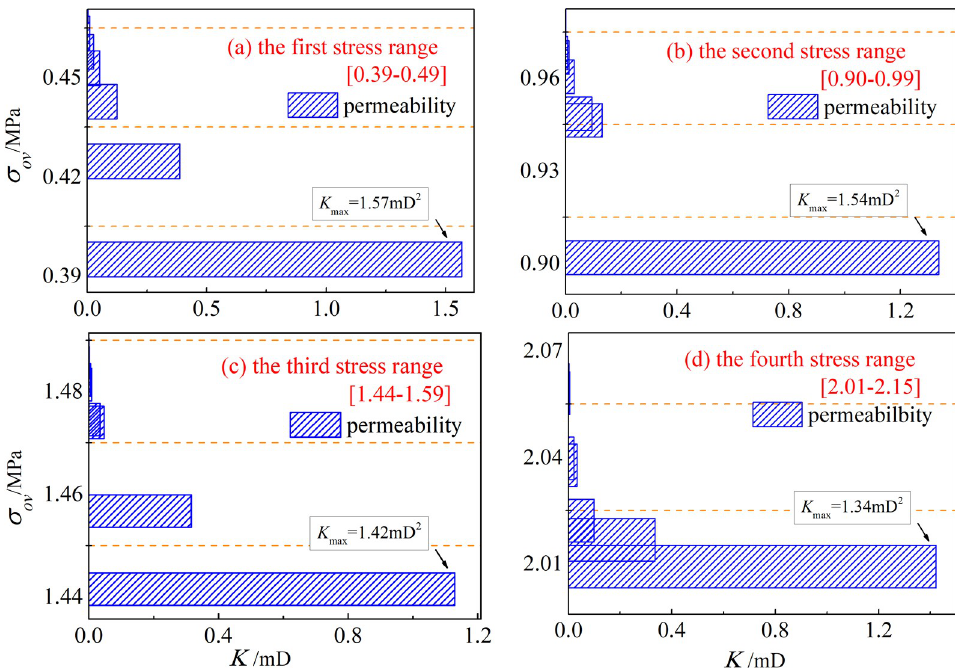
Fig 9. Plot of effective stress versus